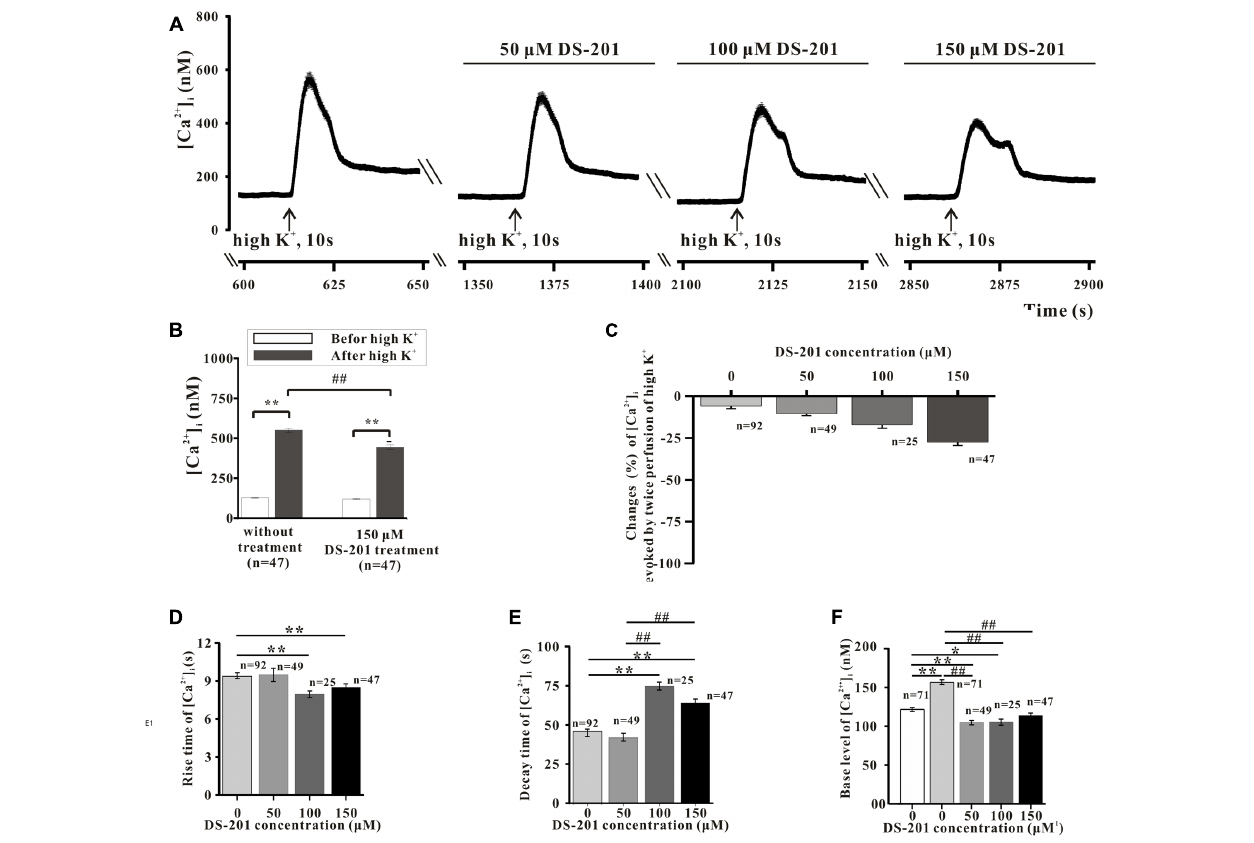
FIGURE 4 | Effect of DS-201 on high K + -induced intracellular Ca 2 + transients in the mesenteric VSMCs of rats. (A) The typical recordings show that the inhibitory effects of DS-201 (50, 100, and 150 µ M) on the Ca 2 + transients induced by high K + was concentration- dependent. The data were obtained with13 cells in one measurement. (B) The effect of 150 µ M DS-201 on high K + -induced changes of intracellular Ca 2 + before or after treatment of 60 mM High K + solution for 10 sec. ∗∗ p < 0.01, between the groups of before and after high K + solution; ## p < 0.01 between the groups of no treatment and DS-201 treatment. The data were obtained with 47 cells from five rats for each group. (C) Concentration-response of DS-201 on high K + -induced intracellular Ca 2 + transients. (D) The rise time of high K + -induced intracellular Ca 2 + transients. (E) The decay time of high K + -induced intracellular Ca 2 + transients and (F) the resting [Ca 2 + ] i levels with different concentrations of DS-201. Note that DS-201 inhibited the increase of base [Ca 2 + ] i level induced by high K + . For C–F : the cells used in the study were labeled at the relative bar from five rats. The post hoc comparison was analyzed with one-way ANOVA followed by student-Newman–Keuls